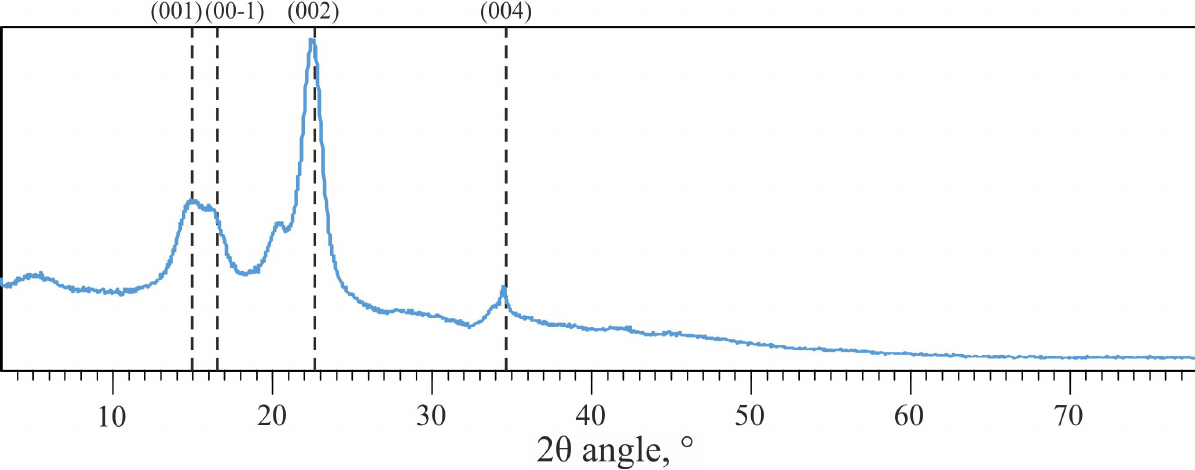
Figure 2. SEM (Scanning Electron Microscopy) images of ARBOCEL ® P 4000 X. PXRD diffractogram of ARBOCEL ® P 4000 X is shown in Figure 3.